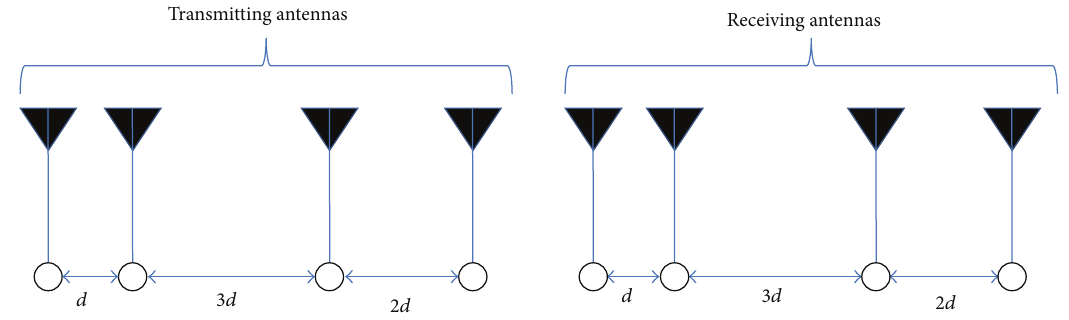
Figure 6: Nonuniform array configuration used in the study ( d = 15mm).